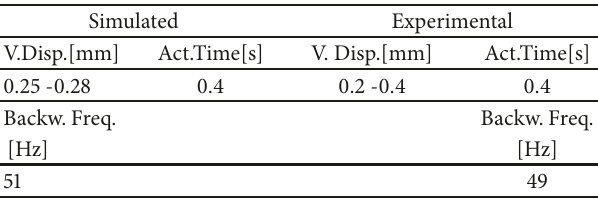
Figure 26: Rotor horizontal displacements during a radial landing experimental test at DE (blue line) and NDE (red line) rotor nodes. Table 1: Radial landing results comparison.